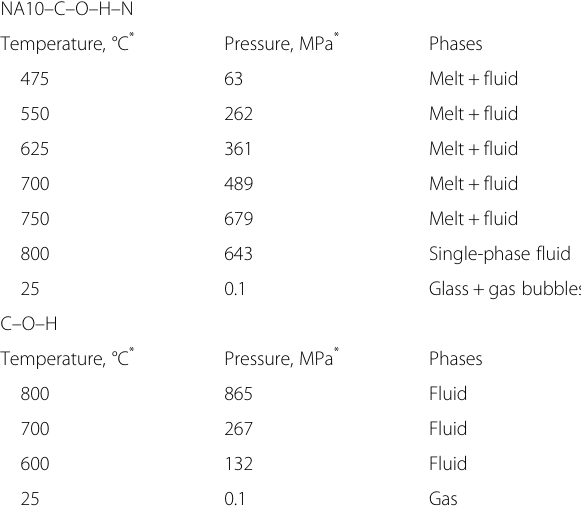
Table 1 Experimental